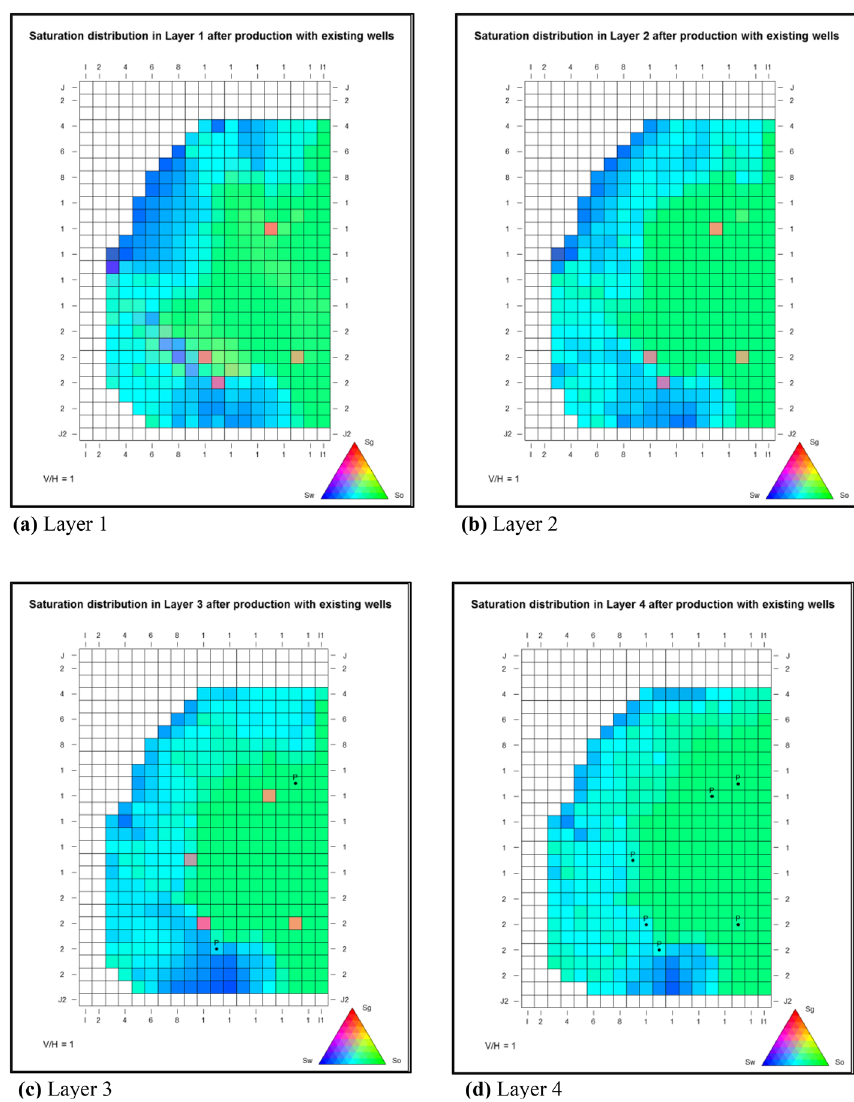
Fig. 6 Saturation distribution maps for various layers of the reservoir with existing wells (15 years simulated production